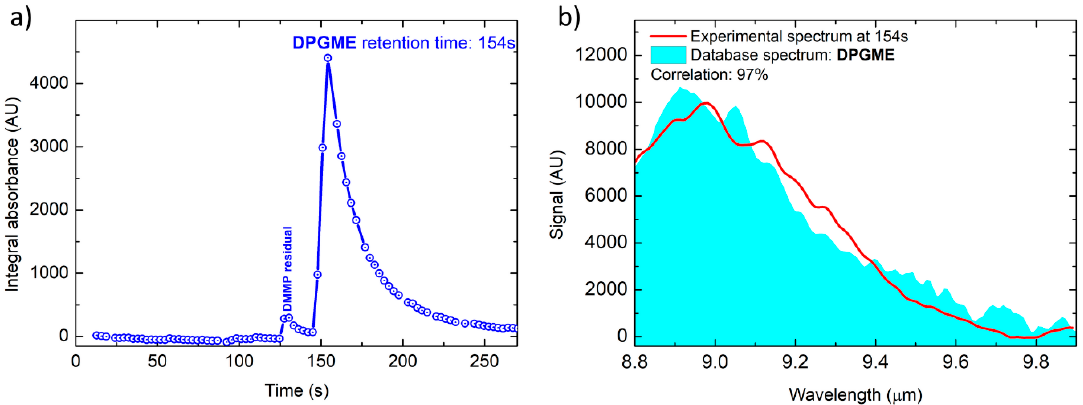
Figure 7. Total absorption chromatogram ( a ) and DPGME spectrum acquired at T = 154 s compared with the library spectrum ( b ).